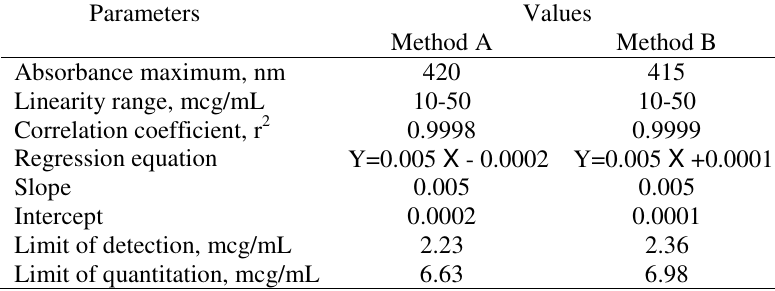
Figure 3. Calibration curve of tadalafil by method B Table 1 . Optical characteristics of the proposed